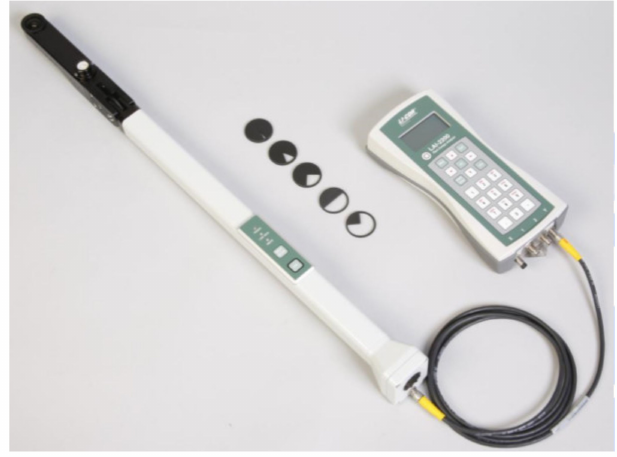
Figure 3. The LAI-2200C canopy